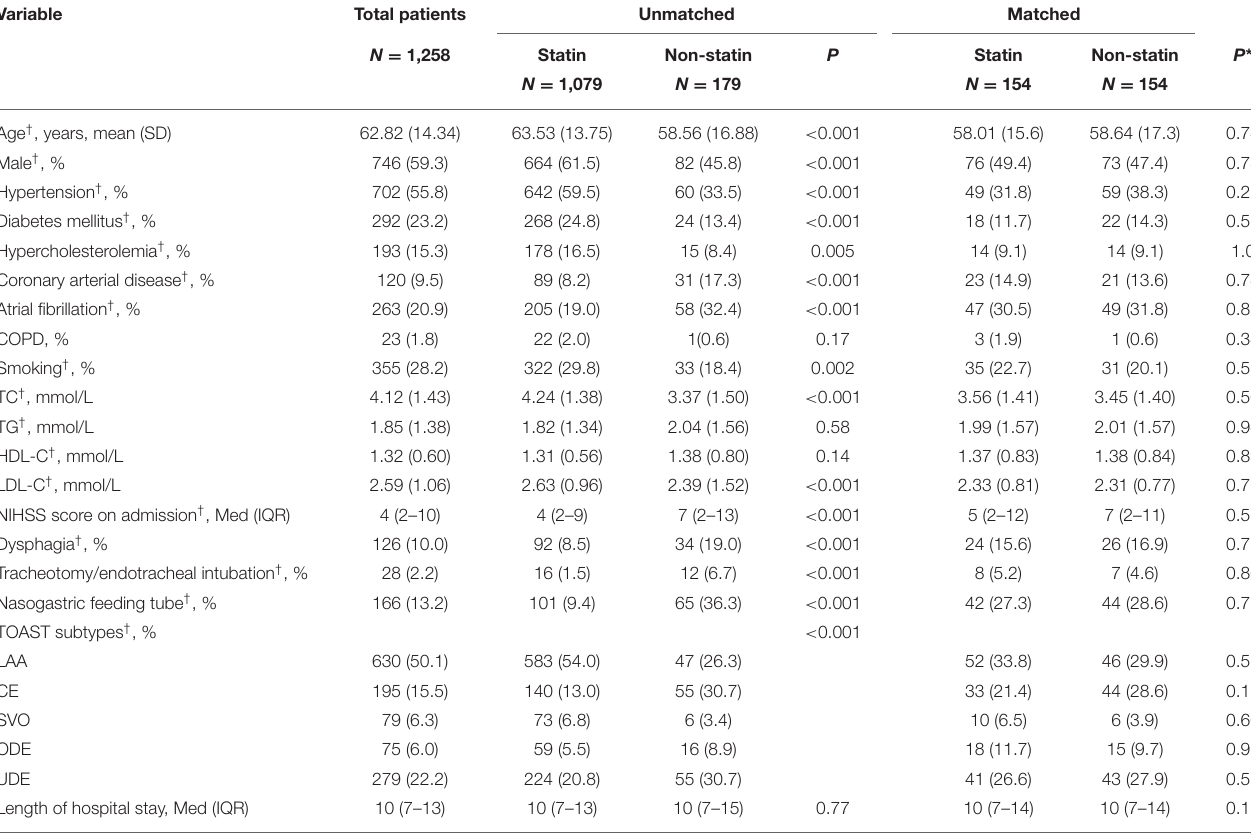
TABLE 1 | Baseline characteristics before and after propensity score matching.